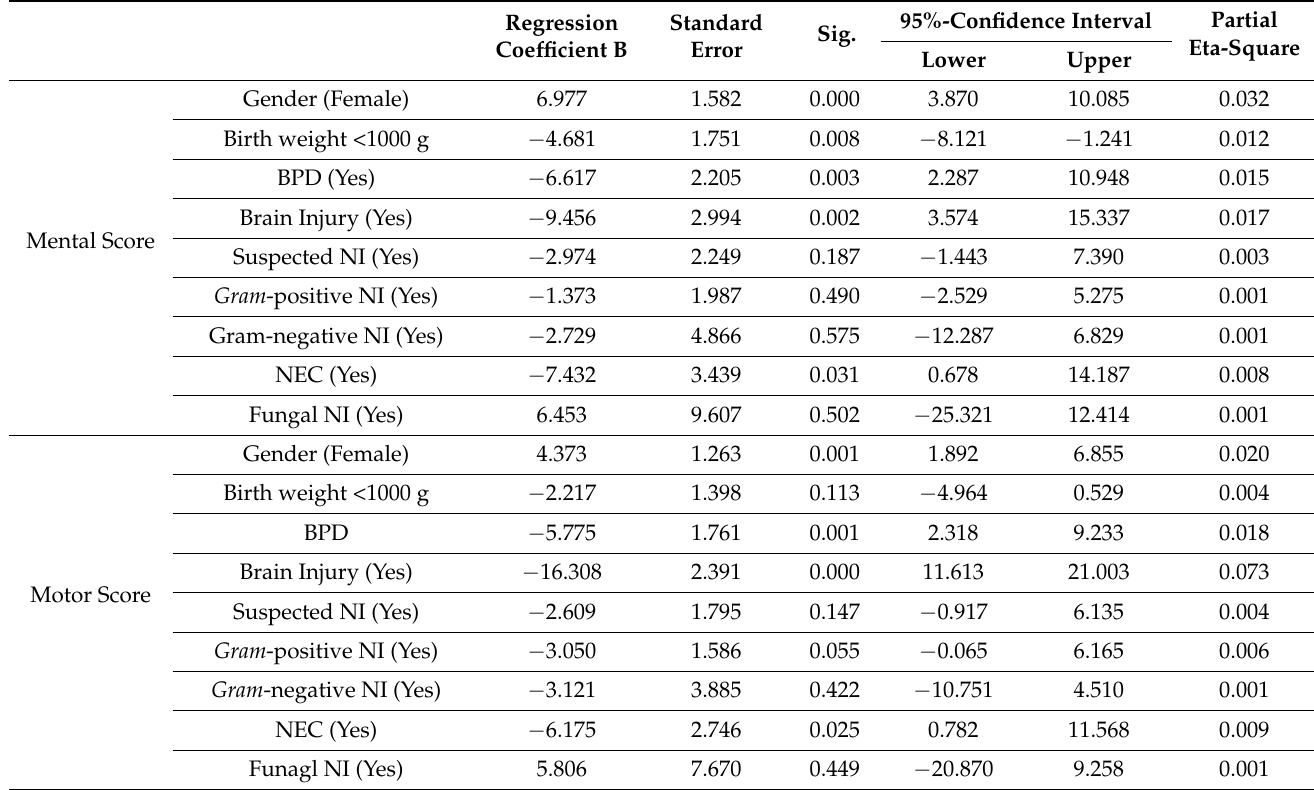
Table 3. Regression model including nosocomial infection